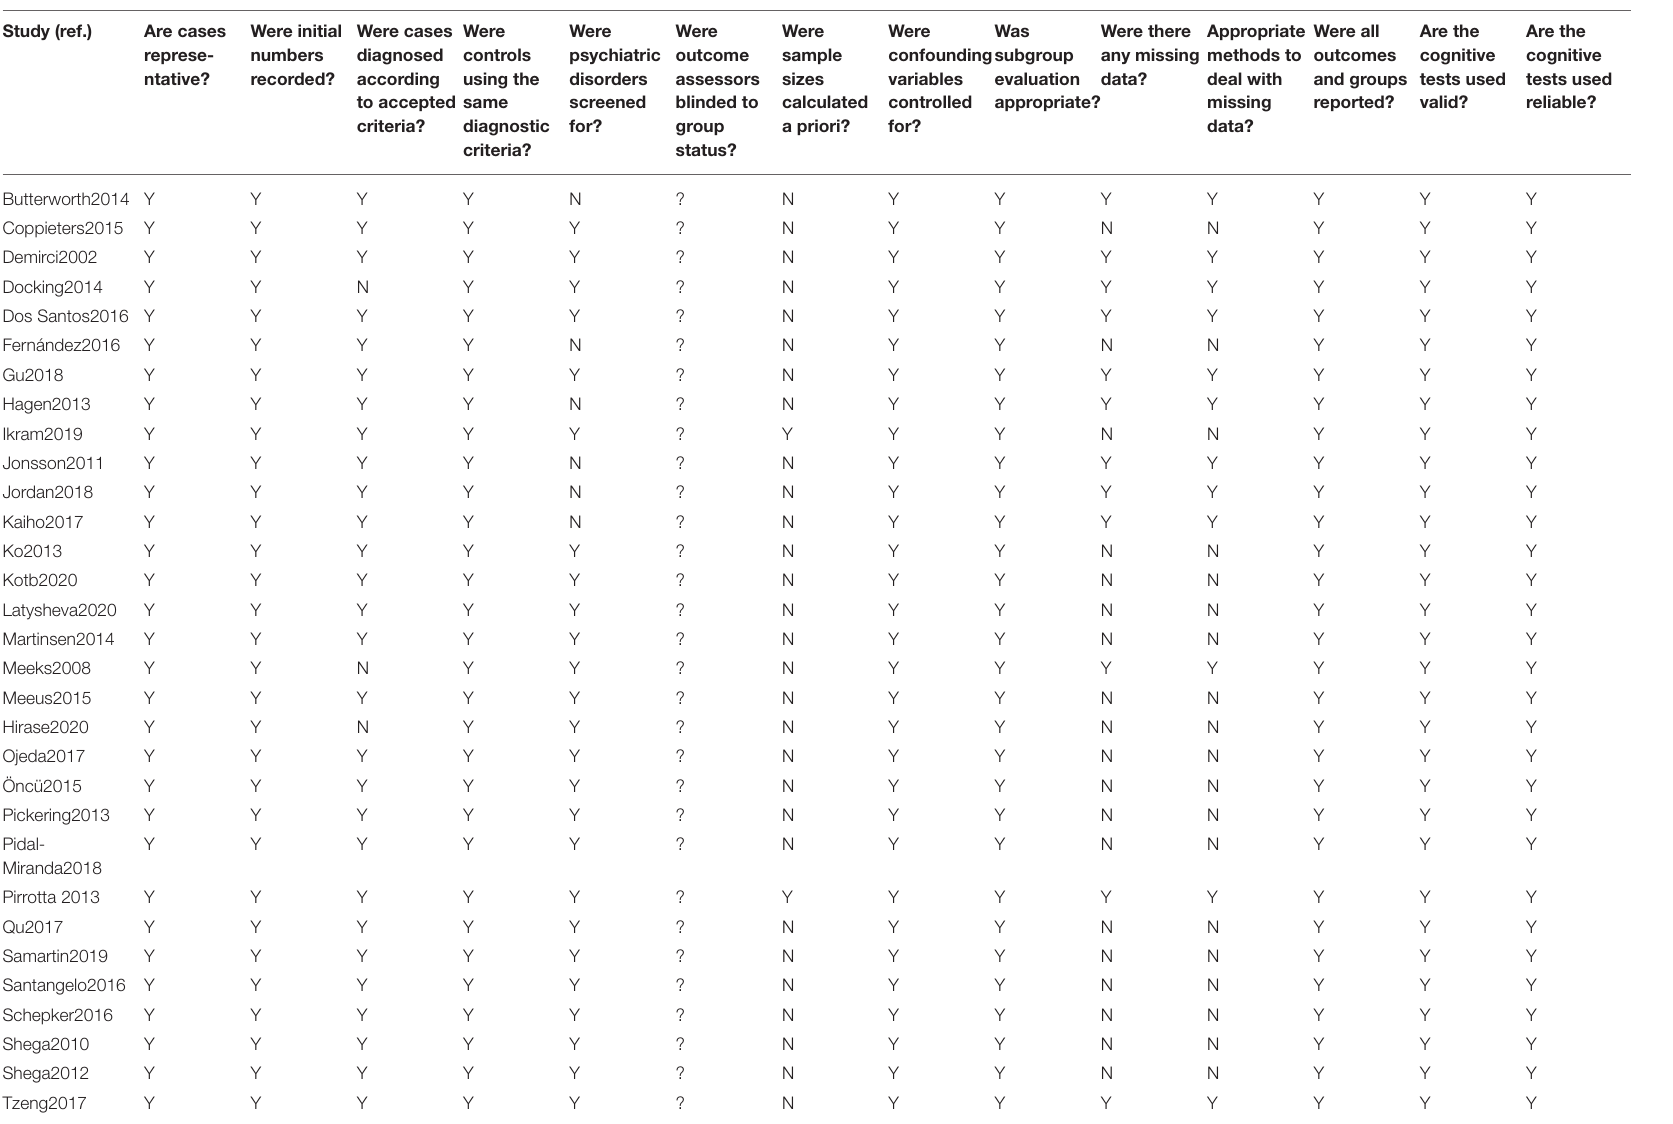
TABLE 2 | Risk of bias of included studies. Study